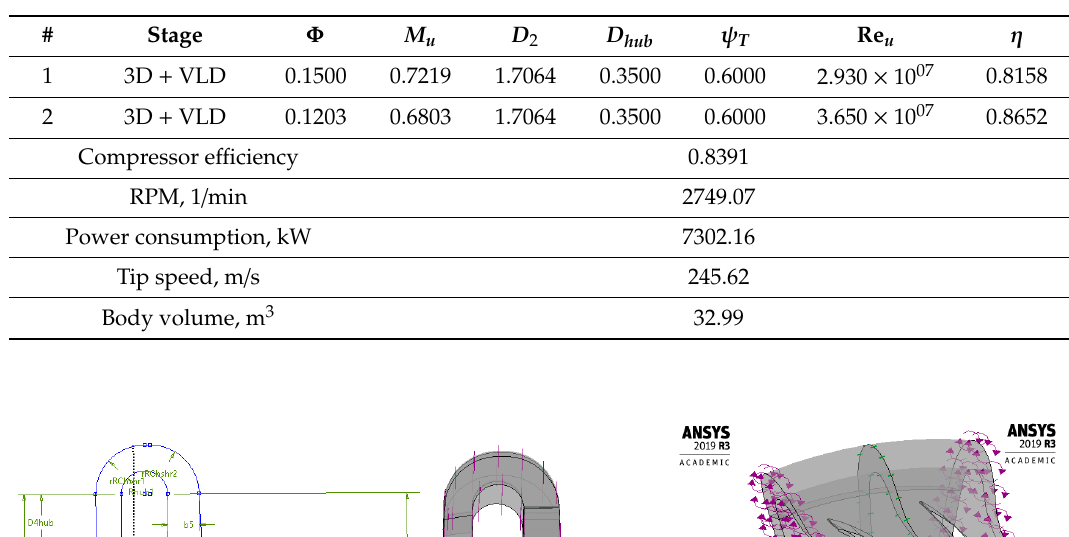
Figure 4. The flow path of the stator part of the stage with Φ des = 0.15 and ψ Tdes = 0.60.